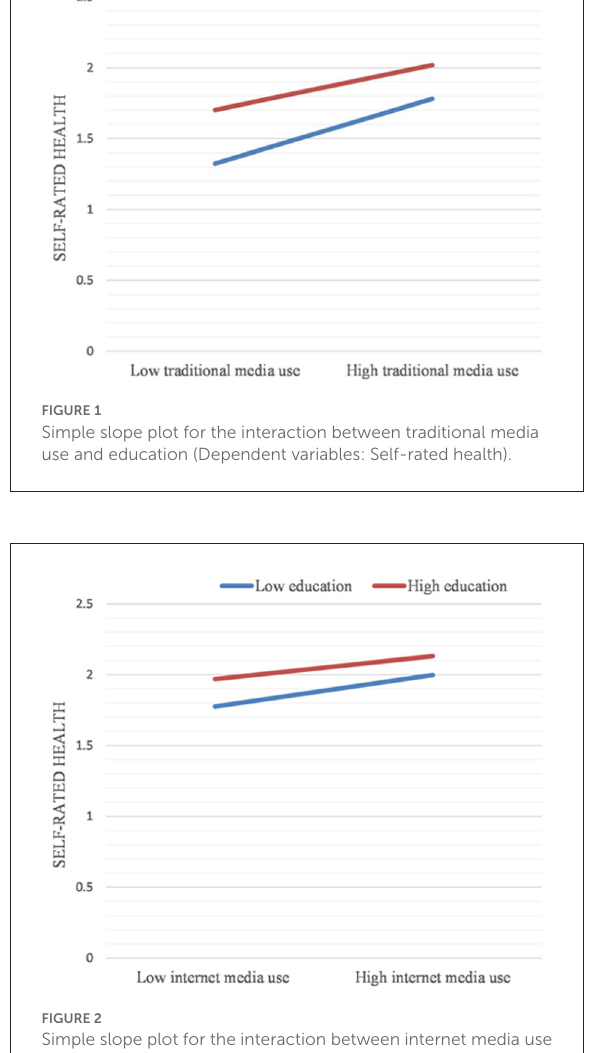
disparities in old people and promoting health and well-being in the elderly